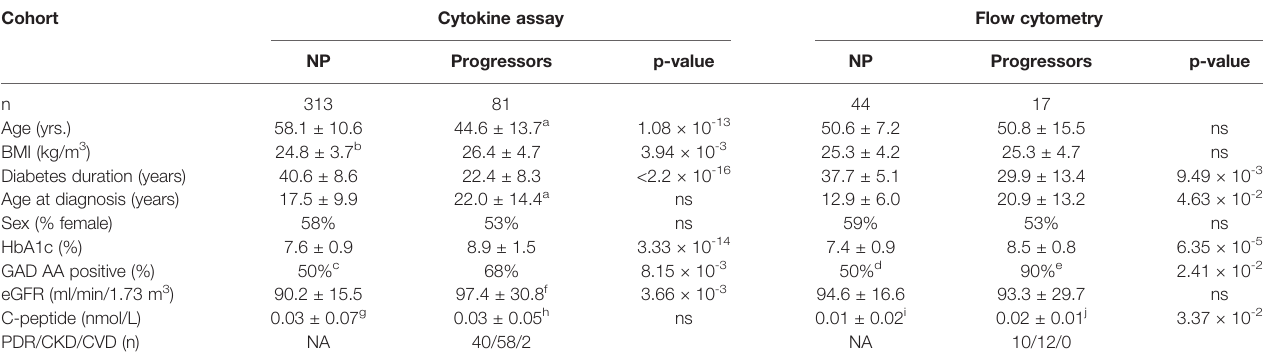
TABLE 2 | Clinical characteristics of the PROLONG participants.